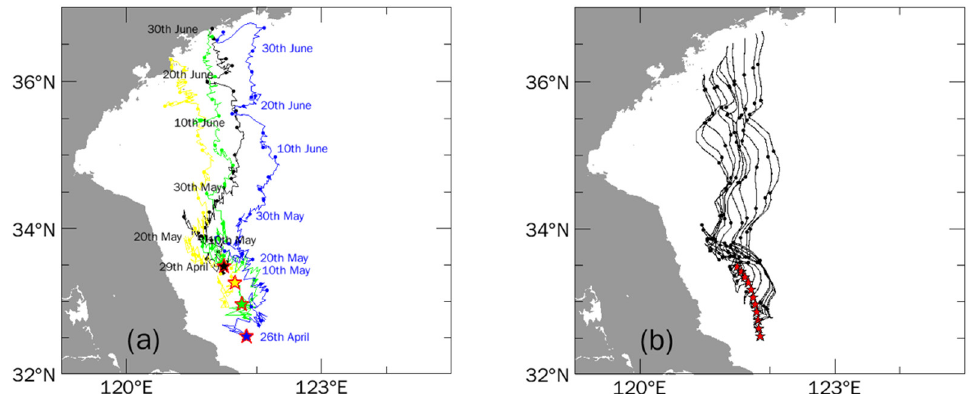
Figure 5. Observed ( a ) and simulated ( b ) trajectories of surface ARGOS drifters released in late April 2021 off the Subei coast. Star markers represent the released locations.